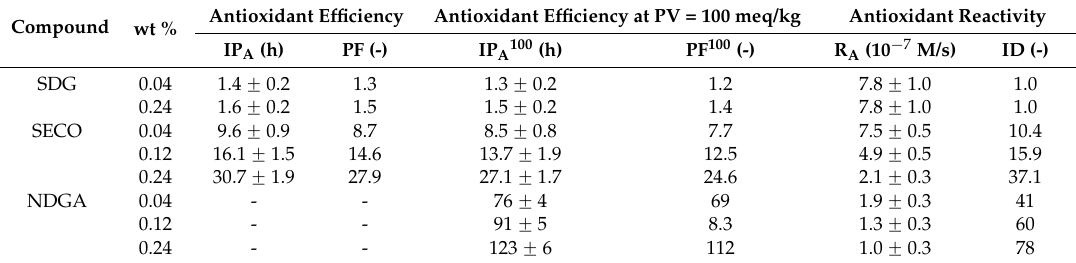
Table 3. Main kinetic parameters, characterizing the TGSO autoxidation process at 80 ˝ C in presence of secoizolariciresinol (SECO), secoisolariciresinol diglucoside (SDG), and nordihydroguaiaretic acid